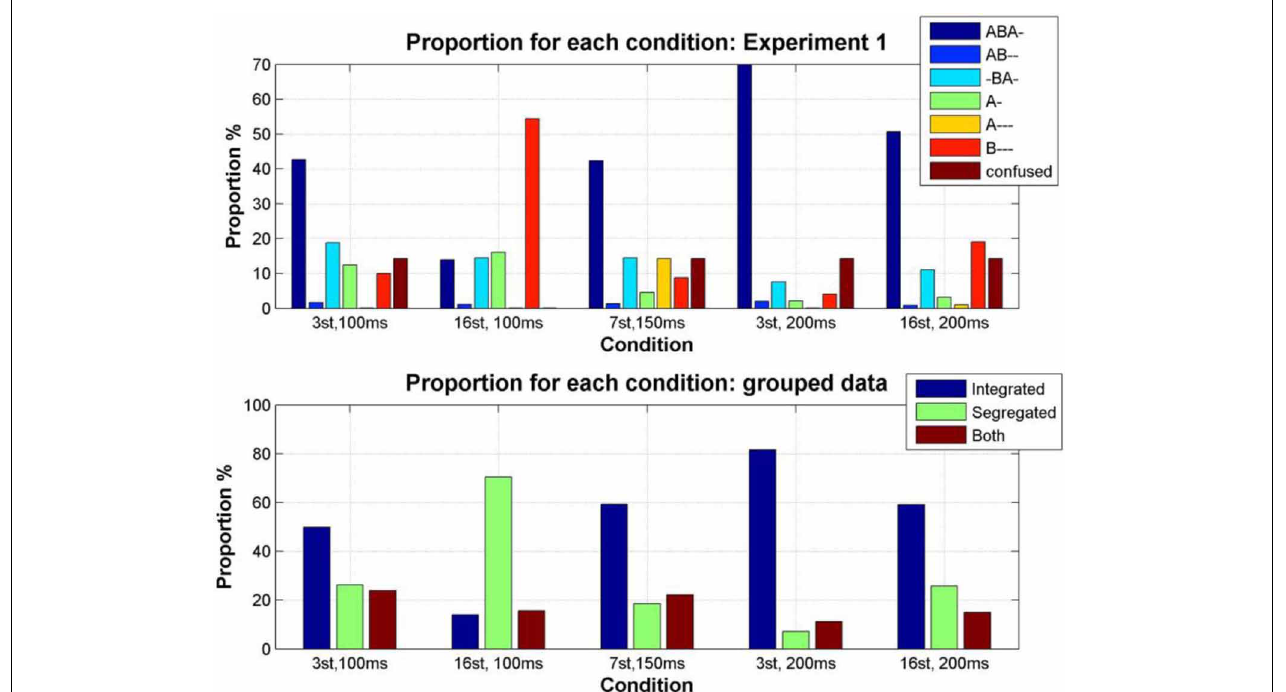
FIGURE 5 | Proportion of the total stimulus duration during which each pattern was perceived (color coded as indicated by the accompanying legend) for each condition, calculated from the condition transition matrices constructed by pooling the data from all participants for each